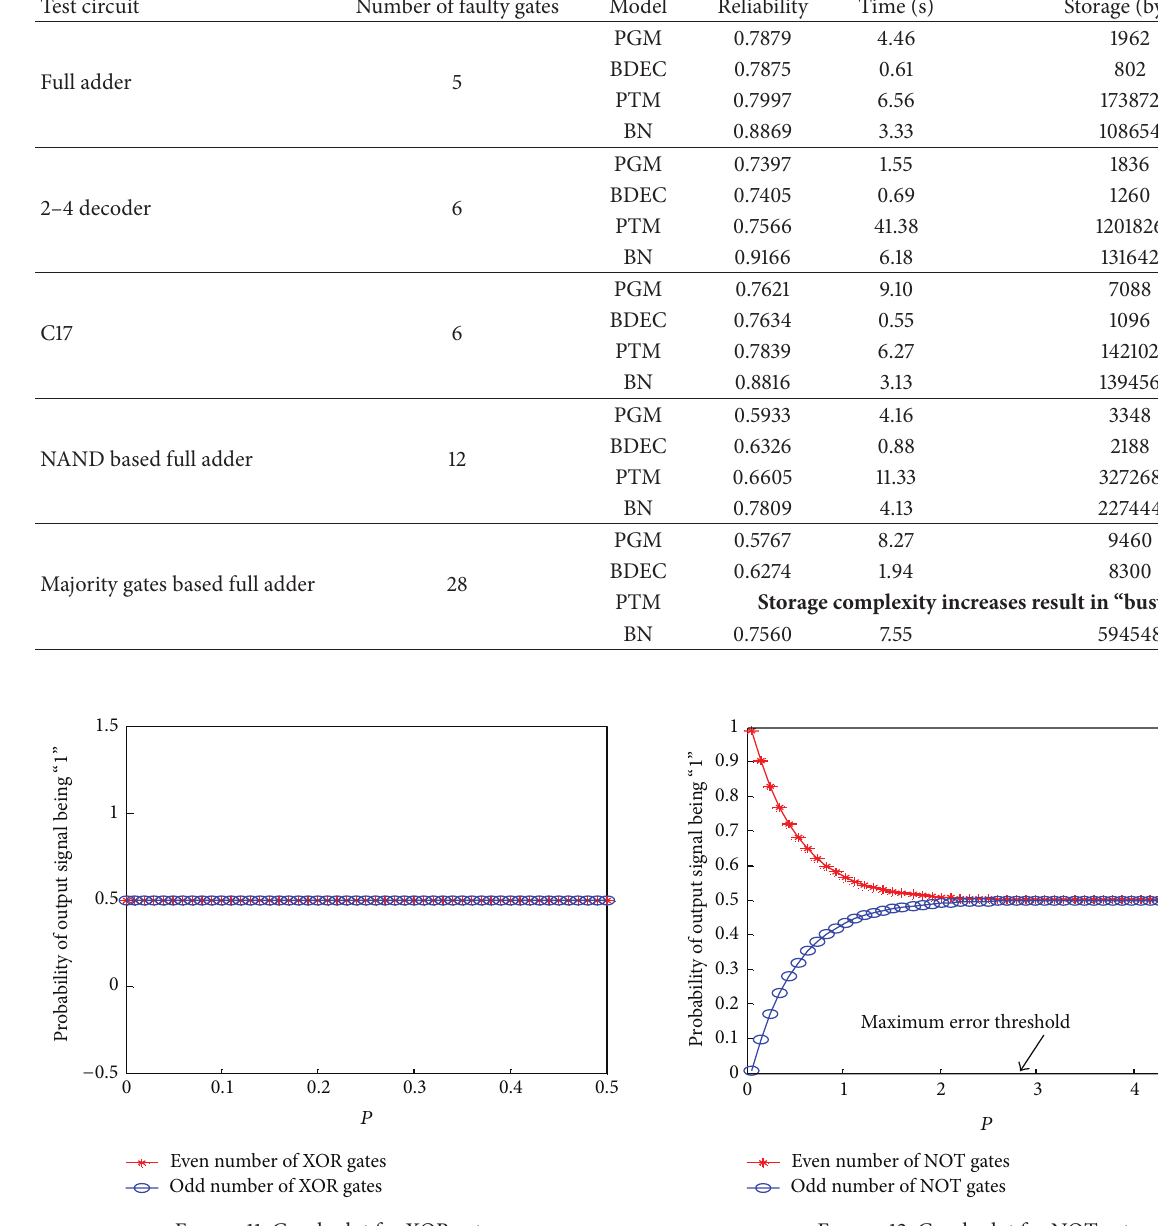
Figure 11: Graph plot for XOR gate. Figure 12: Graph plot for NOT